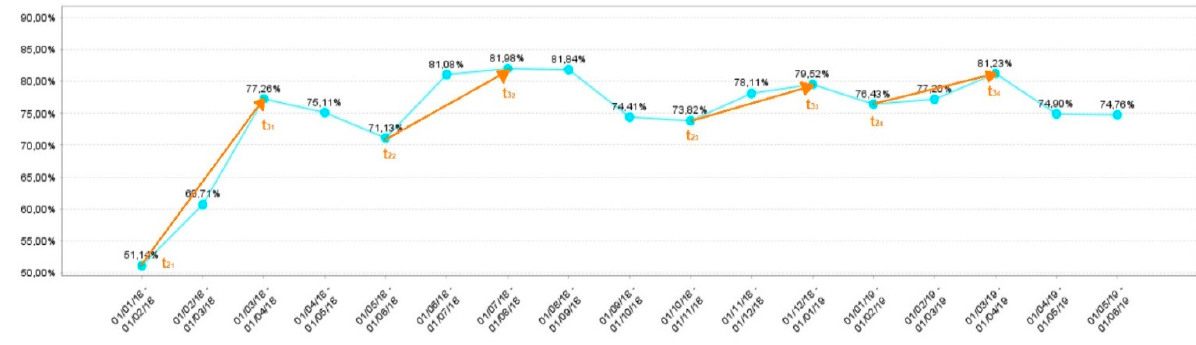
Figure 9. Actual availability of the extraction fleet.